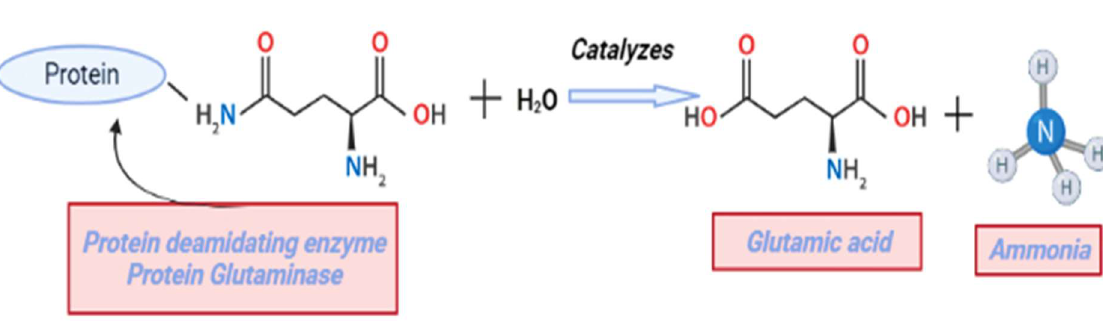
Figure 5. Schematic representation of deamidation process of pea protein by the deamidating